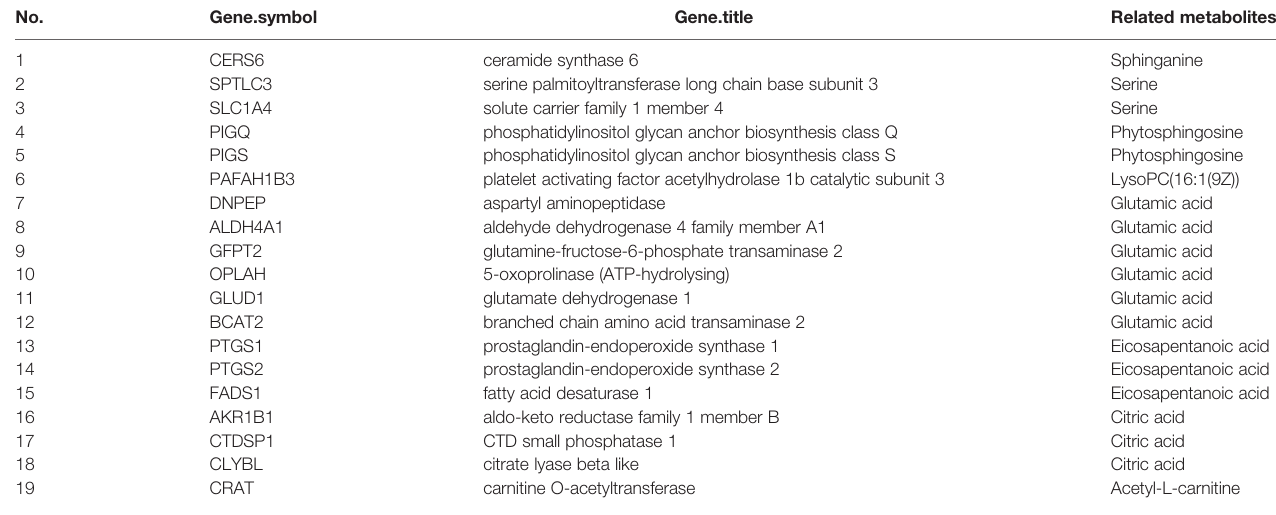
TABLE 5 | The key targets identi fi ed by integration analysis of metabolomic and transcriptomic data. No.